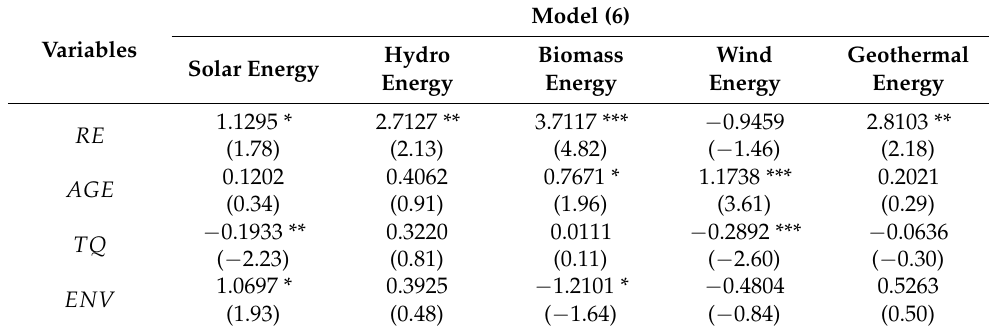
Table 8. Estimation for different energy